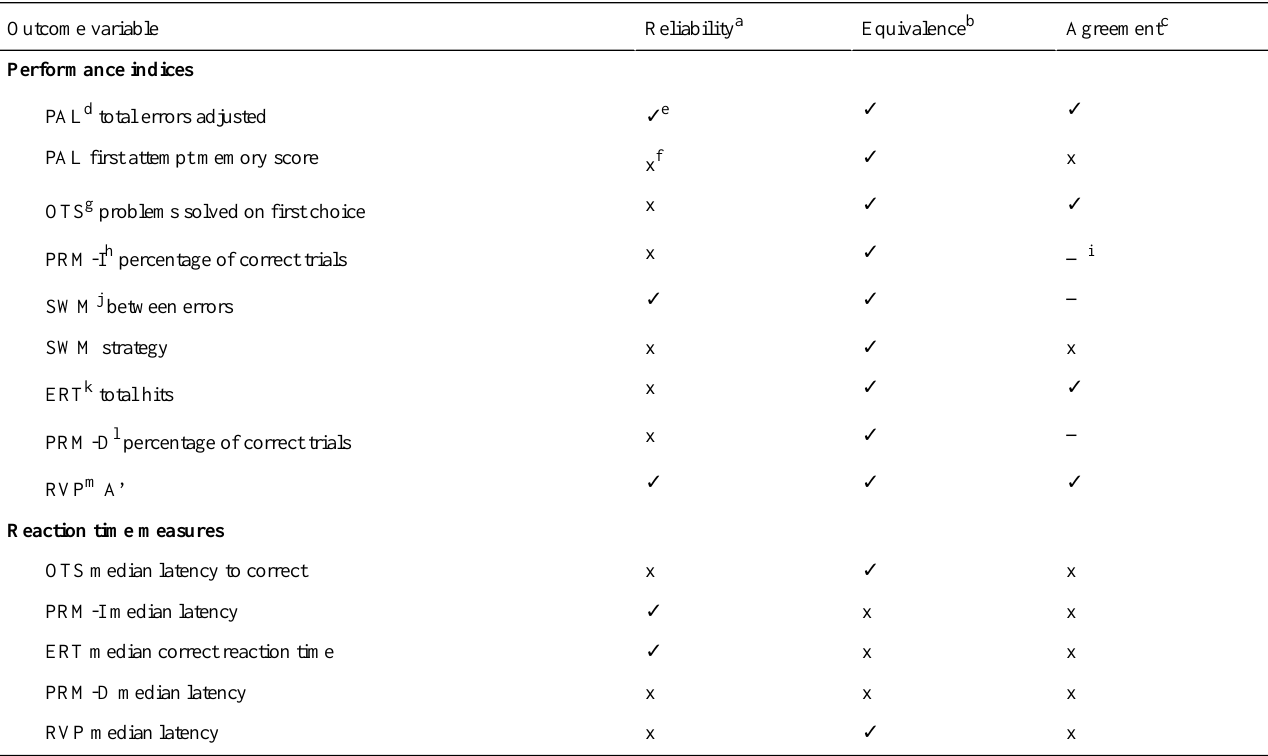
Table 3. The overall assessment of web-based outcome measures with regard to 3